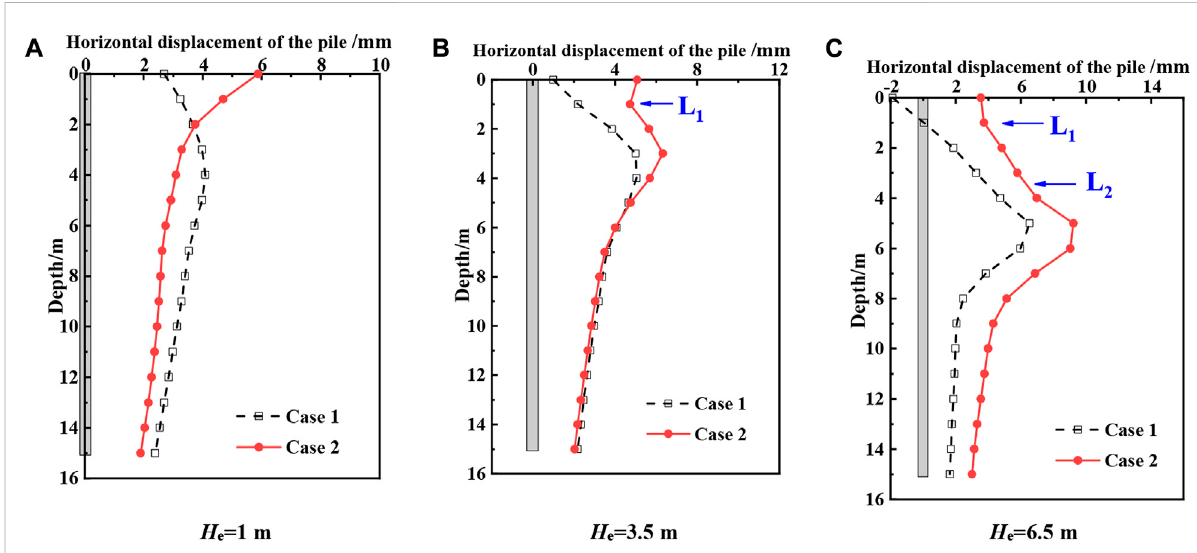
FIGURE 16 Comparison of horizontal displacement of the retaining pile on the right-hand side of the excavation. (A) H e =1 m. (B) H e =3.5 m. (C) H e =6.5 m.